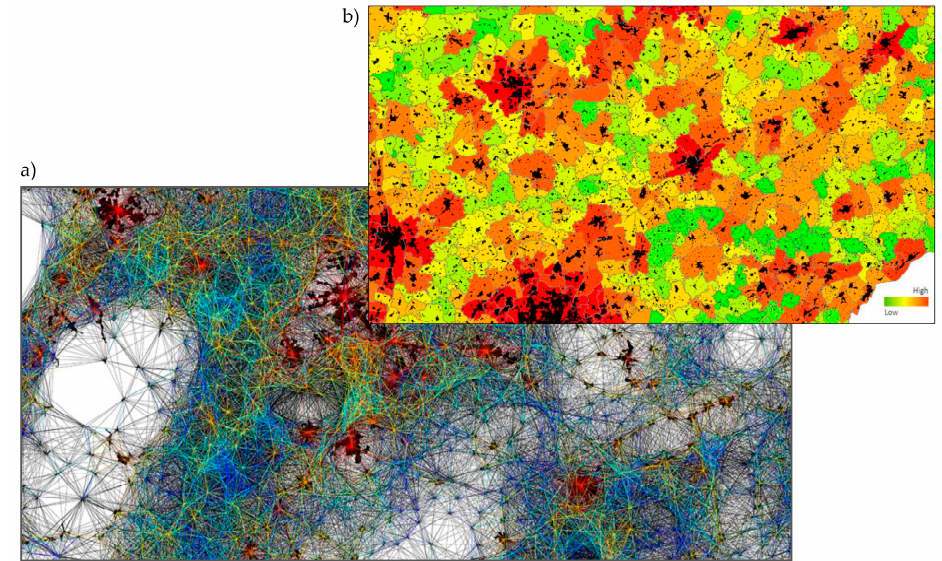
Figure 6. Example of GUF + NetS product ( a ) providing additional information for an analysis of settlements properties and patterns—e.g., local betweeness derived for administrative municipal units as shown in ( b ).